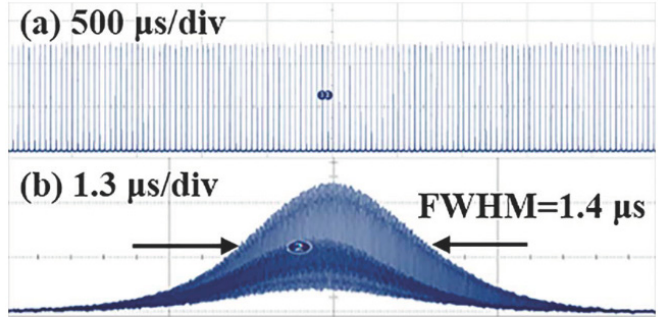
Figure 4. ( a ) Oscilloscope traces of a stable QML pulses train at 23.8 kHz and ( b ) expanded temporal shape of a single QML pulse.